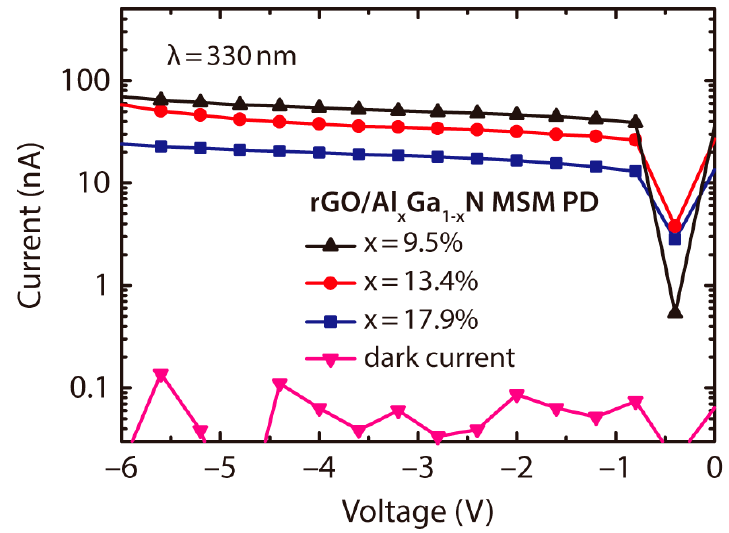
Figure 4. Current–voltage ( I – V) characteristics of the rGO/AlGaN MSM photodiodes under dark and under 330 nm of illumination.